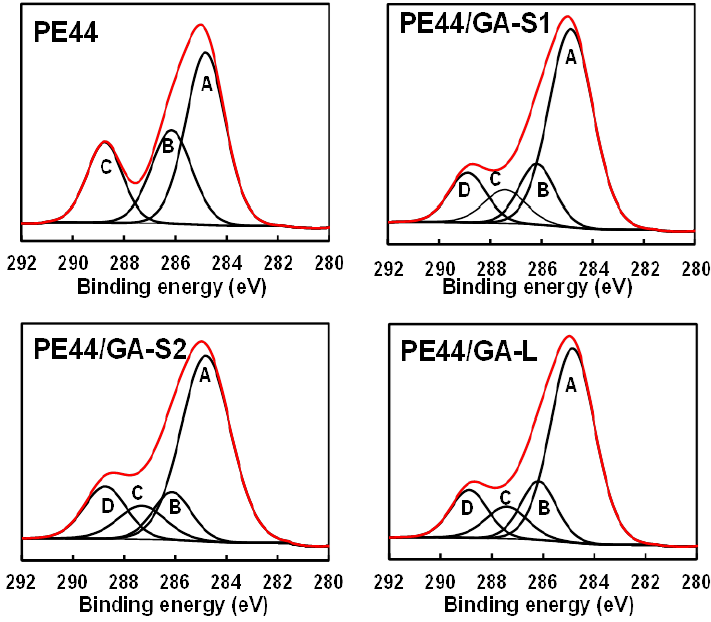
Figure 5. High-resolution XPS spectrum at the C 1s region for unloaded and GA-loaded PE44 fibers. The red line corresponds to the experimental profile while the black lines are the peaks from deconvolution. Unloaded PE44: C–C/C–H (A: 284.8 eV), C–O (B: 286.1 eV) and C=O (C: 288.7 eV). GA-S1, GA-S2 and GA-L loaded PE44: C–C/C–H (A: 284.9 eV), C–O (B: 286.2 eV), (O=)C–NH peptide bond (287.7) and C=O (C: 288.8 eV).